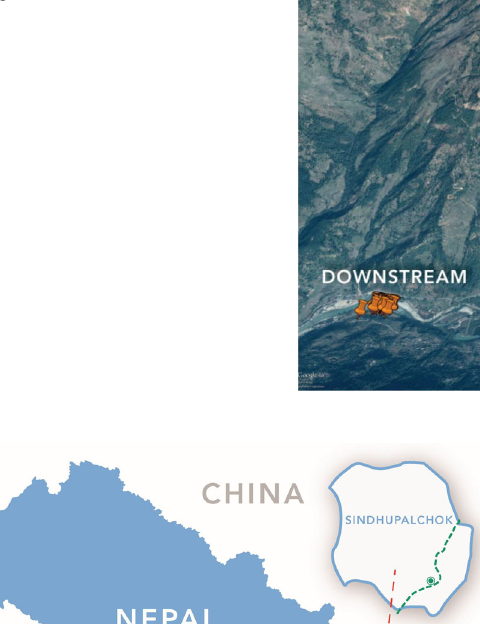
Fig. 2 Spatial distribution of the respondent households. Source Google Earth.